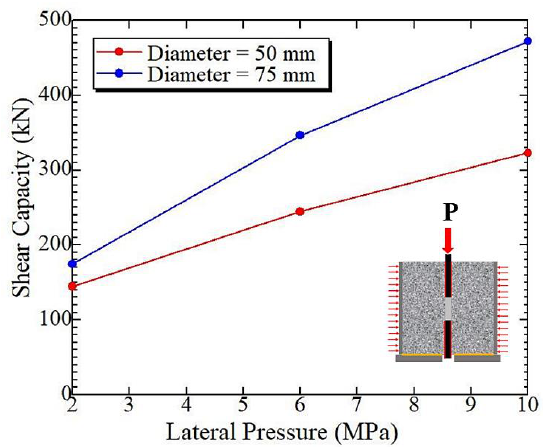
Figure 14. Illustration of the combined effects of the lateral pressures and the diameters of the holes on analytical shear capacities.